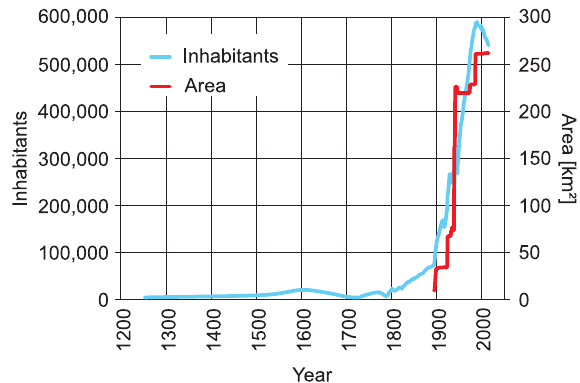
Fig. 10. Changes of inhabitants and area of Poznań city (acc. different historical and statistical data, mainly acc. kruszka